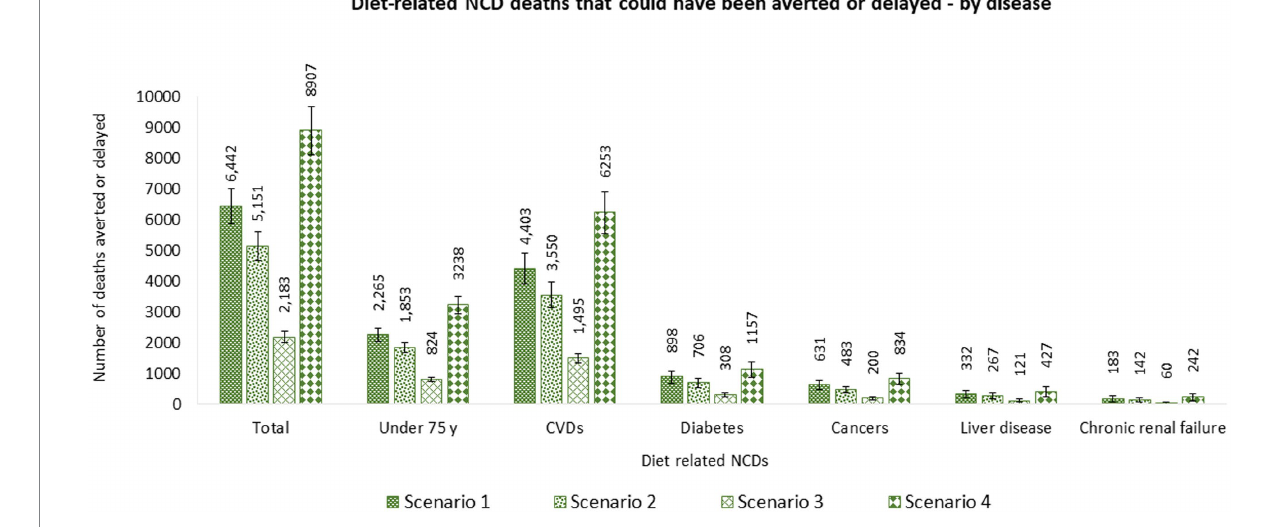
FIGURE 4 Number of diet-related NCD deaths that could be averted or delayed from implementing a ‘high in’ FOPL in Canada by disease. Potential diet-related NCD deaths that could be averted or delayed were estimated using the PRIME model (67). Inputs for the model included, (1) population demographics; (2) mortality data associated with diet-related NCDs (CVDs, diabetes, cancer, chronic renal failure, and liver disease) (2019), obtained from the publicly available Statistics Canada CANSIM tables (stratified by sex and 5-year age band) (91–96); and (3) baseline and counterfactual dietary intakes estimations using CCHS-Nutrition 2015 PUMF data (61, 63). Counterfactual scenario 1 and 2 were based on Taillie et al. (44). SCENARIO 1, overall changes: sodium (mg) –4.7%; sugars (g) –10.2%; saturated fat (g) –3.9%; and SCENARIO 2, disaggregated by foods: sodium (mg) –4.6%; sugars (g) –5.4%; saturated fat (g) –3.6%; and beverages: sodium (mg) –5.2%; sugars (g) –13.2%; saturated fat (g) –5.6%. Counterfactual scenario 3 was based on Acton et al. (40). SCENARIO 3, relative changes disaggregated by snack foods: sodium (mg) –6.3%; sugars (g) –0.1%; saturated fat (g) –6.5%; and beverages: sodium (mg) –5.5%; sugars (g) –8.7%;saturated fat (g) –19.5%. Counterfactual scenario 4 was based on Song et al. (41). SCENARIO 4, overall changes: sodium (mg) –7.8%; sugars (g) –7.3%; saturated fat (g)